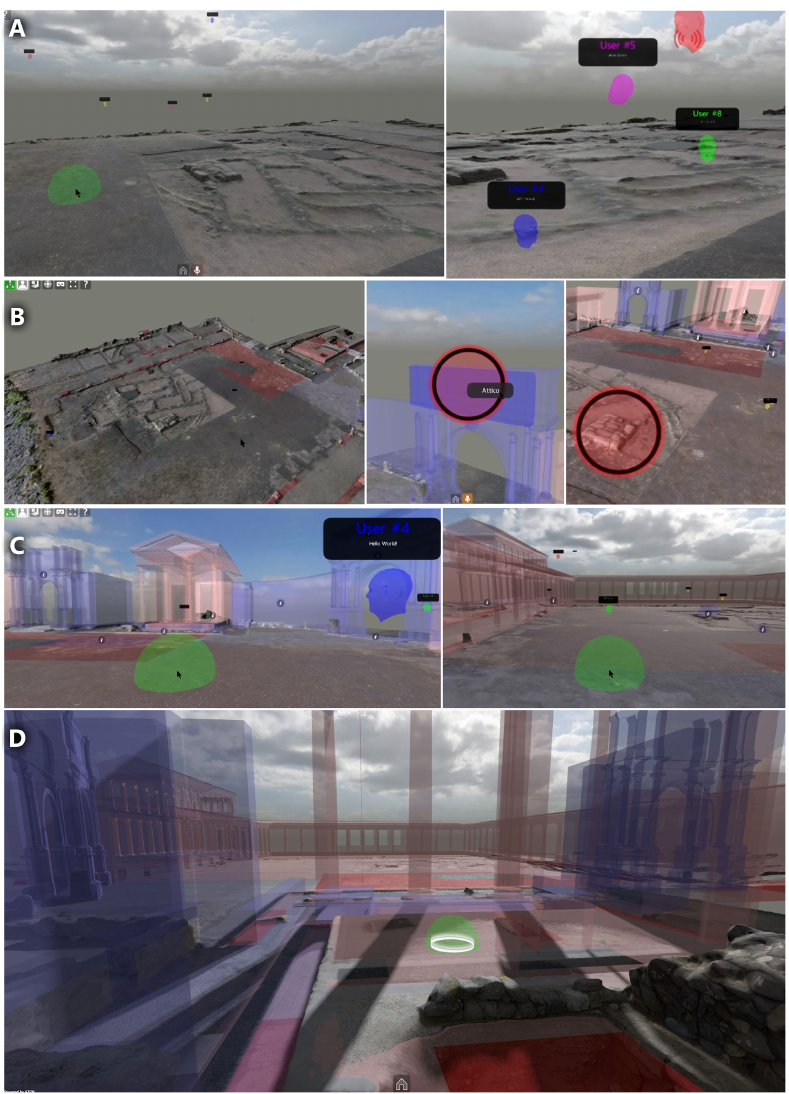
Figure 21. Captures from the collaborative session using a web browser. ( A ) Participants enter the session and gather as the virtual guide (red) starts the explanation; ( B ) The guide progressively activates reconstruction layers (semi-transparent volumes) and uses focus streaming to raise attention on specific hotspots; ( C ) virtual discussion phases; ( D ) The 3D scene with all layers